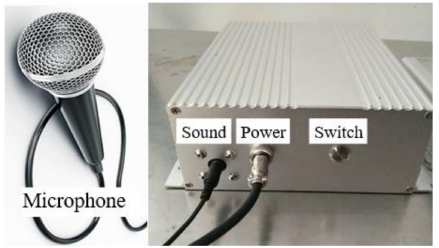
Figure 6. Monitoring device for